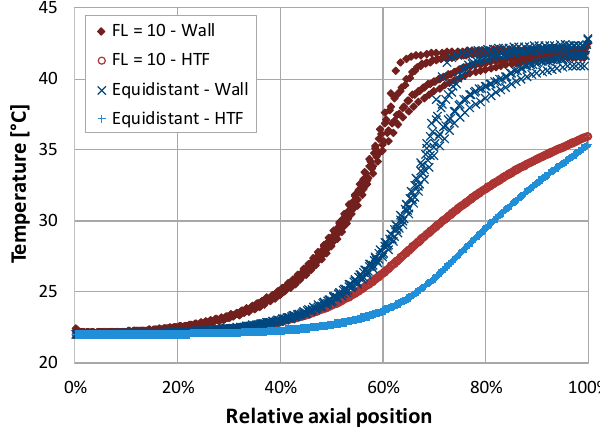
Figure 8. Heat transfer fluid (HTF) and wall element center temperatures of two distributions at 5000 s physical time.